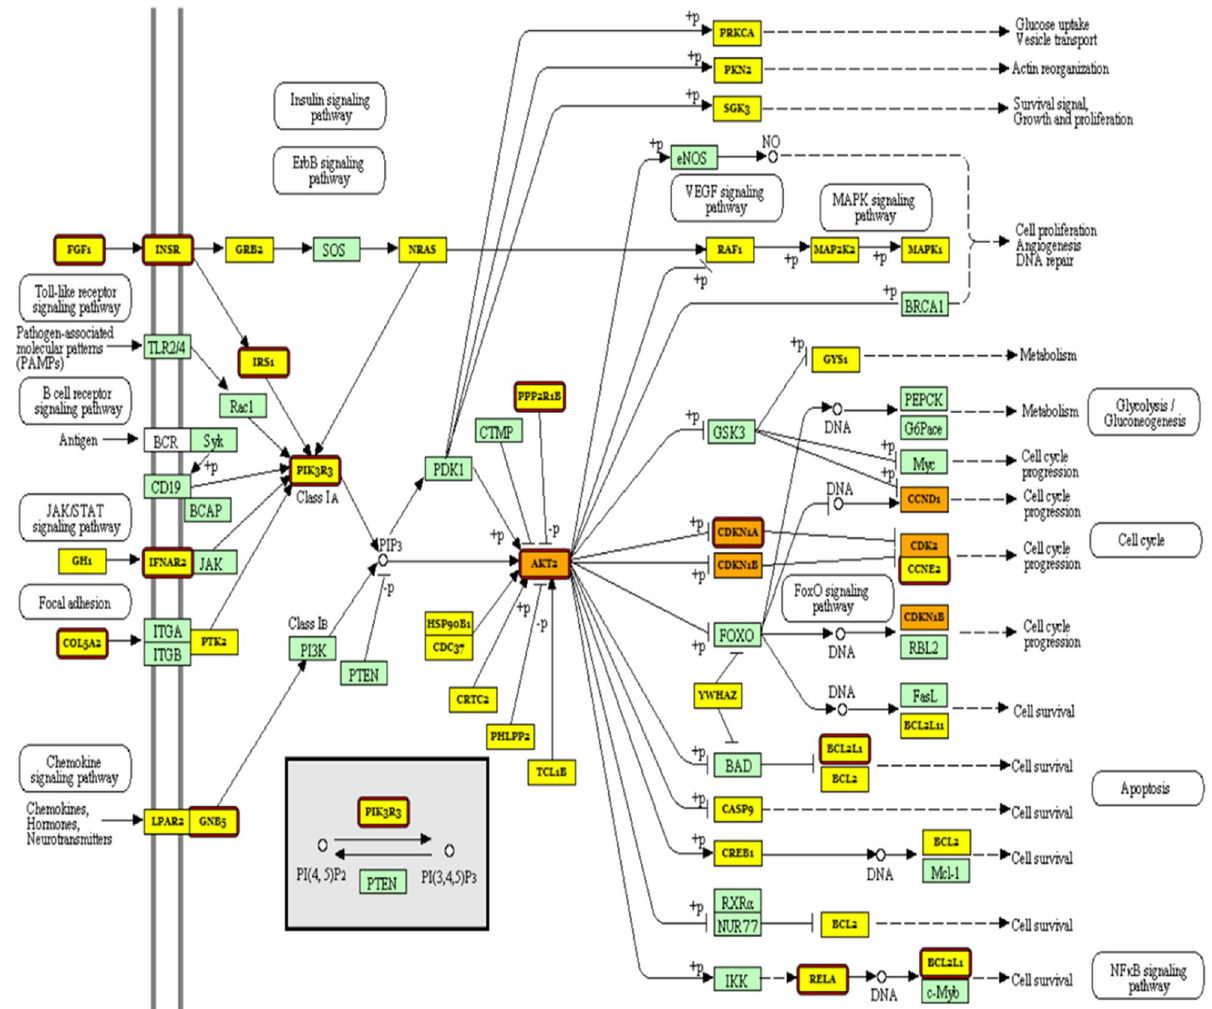
Figure 4. Pathway analysis of the selected miRNAs target genes in KF-Tx cells. Target genes of the selected miRNAs are clustered into pathways using KEGG database 16 .Genes targeted by one miRNA (yellow boxes) and genes targeted by more than one miRNA (orange boxes) are shown. Multiple key genes that are upregulated in KF-Tx cells are shown in red-framed boxes. Green color boxes indicate genes which are not target for selected